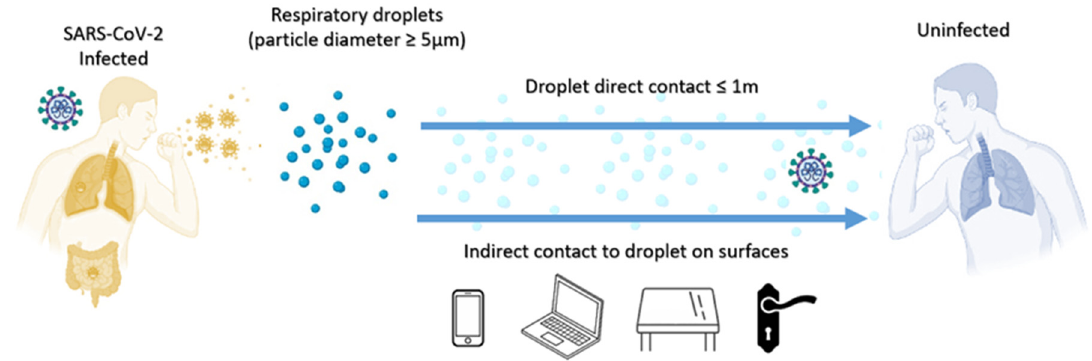
Figure 8. Delta variant droplet transmission.